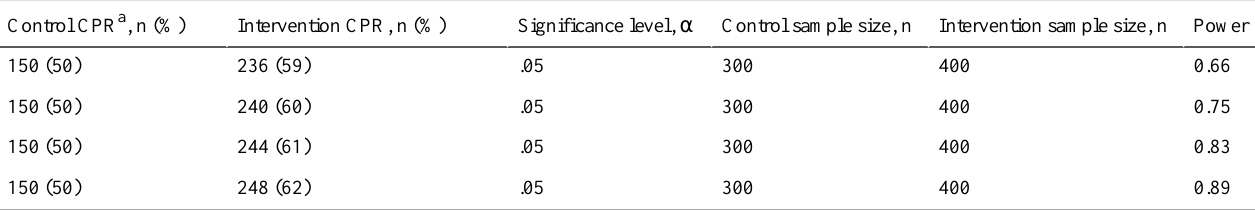
Table 6. Power calculations for contraceptive prevalence rate, targeted counseling